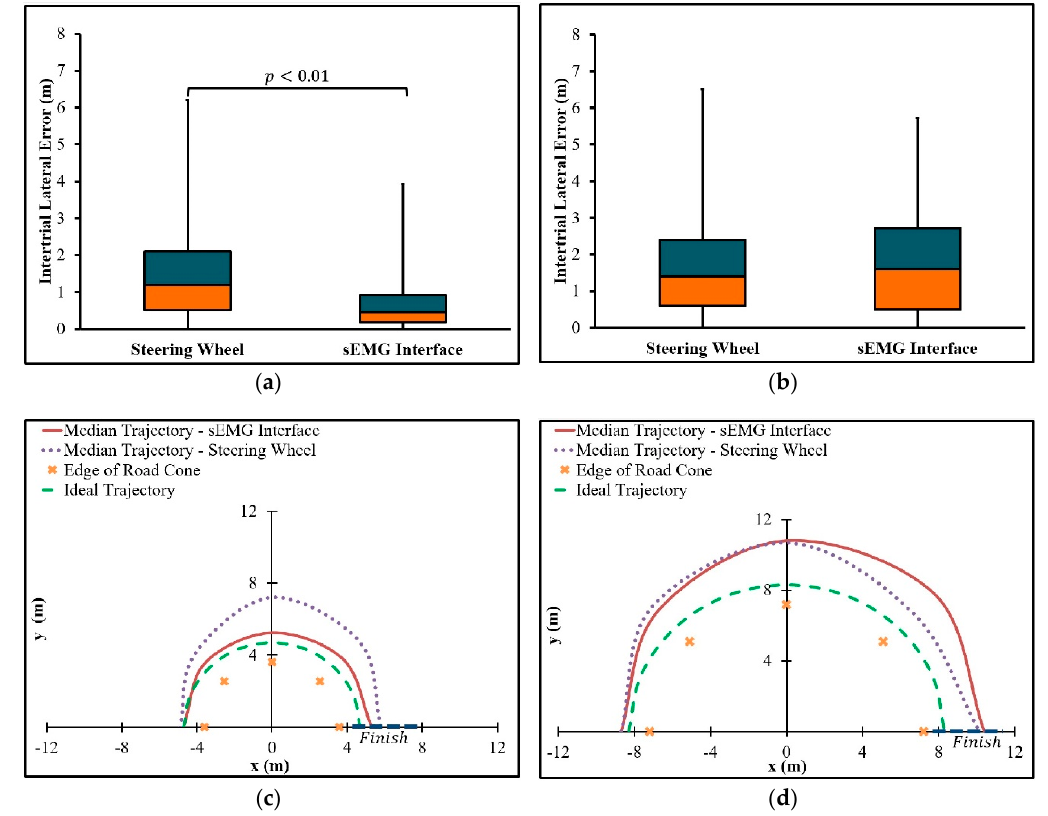
Figure 9. Path-following accuracy of sEMG interface and game steering wheel for U-turns with radii of curvature equal to ( a ) 3.6 m and ( b ) 7.2 m. Corresponding steering trajectories are shown for U-turns with radii of curvature equal to ( c ) 3.6 m and ( d ) 7.2 m.